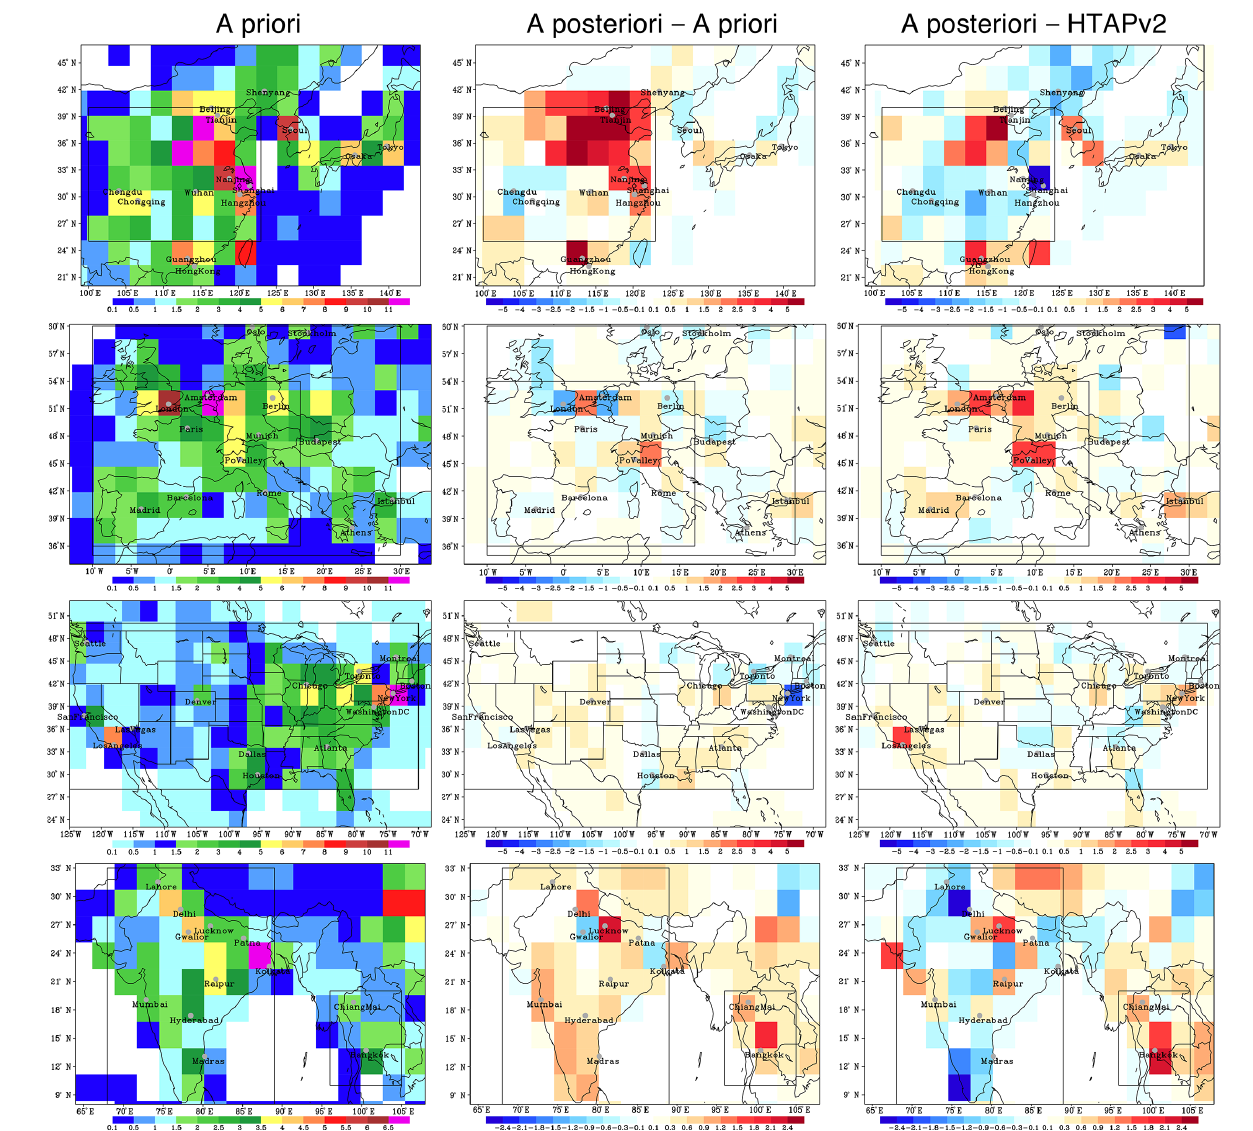
Figure 10. The regional distribution of 10-year mean surface NO x emissions (in 10 − 11 kgm − 2 s − 1 ) over East Asia (upper panels), Europe (upper middle panels), the USA (lower middle panels), and South-east Asia (lower panels) obtained from the a posteriori emissions in the period 2005–2014 (left panels), and the difference between the a posteriori emissions and a priori emissions in the period 2005–2014 (centre panels), and between the a posteriori emissions and EDGAR-HTAP v2 emissions for the years 2008 and 2010 (right panels). The black square line represents the region used for the regional mean